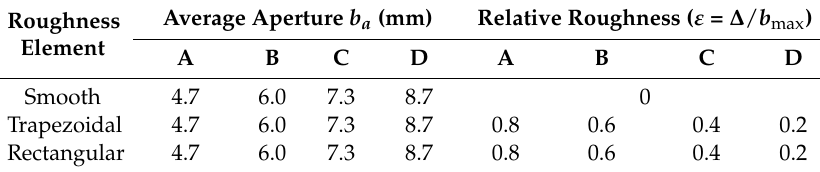
Figure 1. Schematic figure of the experimental setup. Table 1. Average aperture and relative roughness for different single fractures.